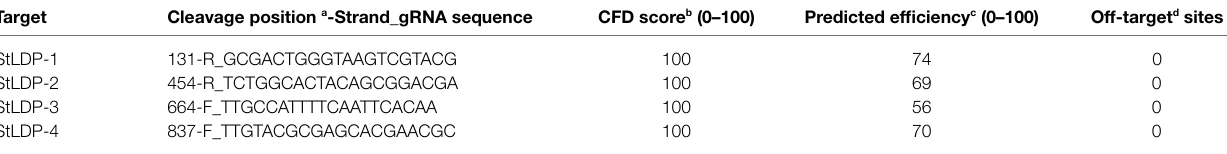
TABLE 1 | List of targets used for episome-mediated multiplexed editing of the StLDP gene. Target Cleavage position a -Strand_gRNA